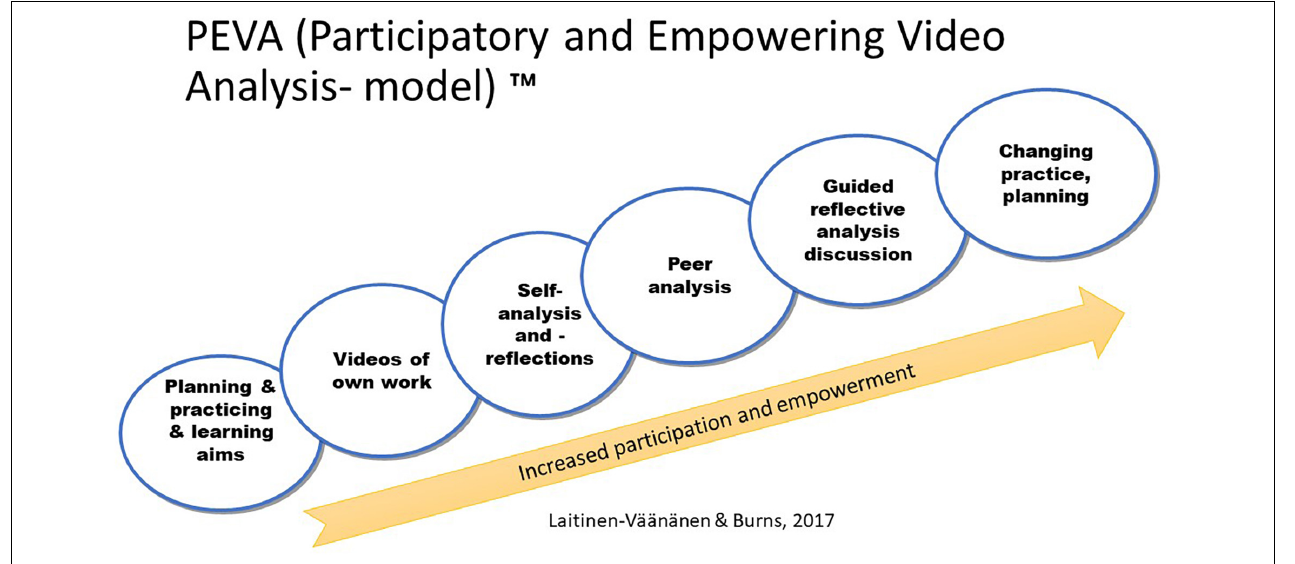
FIGURE 1 | Participatory and Empowering Video Analysis- model,